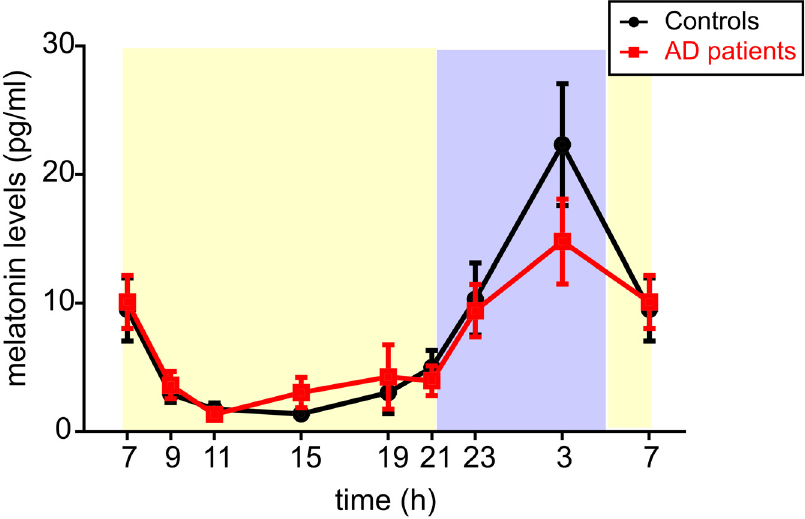
Fig 5. Daily profiles of melatonin levels in the saliva of controls and AD patients. Melatonin levels were detected during the 24 h and expressed in pg/ml. (A) The daily melatonin profiles expressed as the means ± S.E.M. in controls (black circles and black lines, n = 13) and AD patients (red squares and red lines, n = 13); (B) The individual melatonin levels in controls (black circles) and AD patients (red squares) are depicted. Moreover, the mean cosine fits (black curve for controls and red curve for AD patients) were obtained by the cosinor analysis. X-axes represent the time of day in hours, the blue and yellow areas on the graphs backgrounds correspond with time of the outside darkness and daylight, respectively, as occurred during the recording